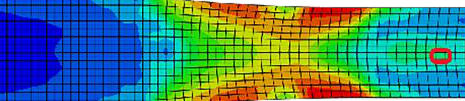
Figure 3. selected element(middle part of red circle).